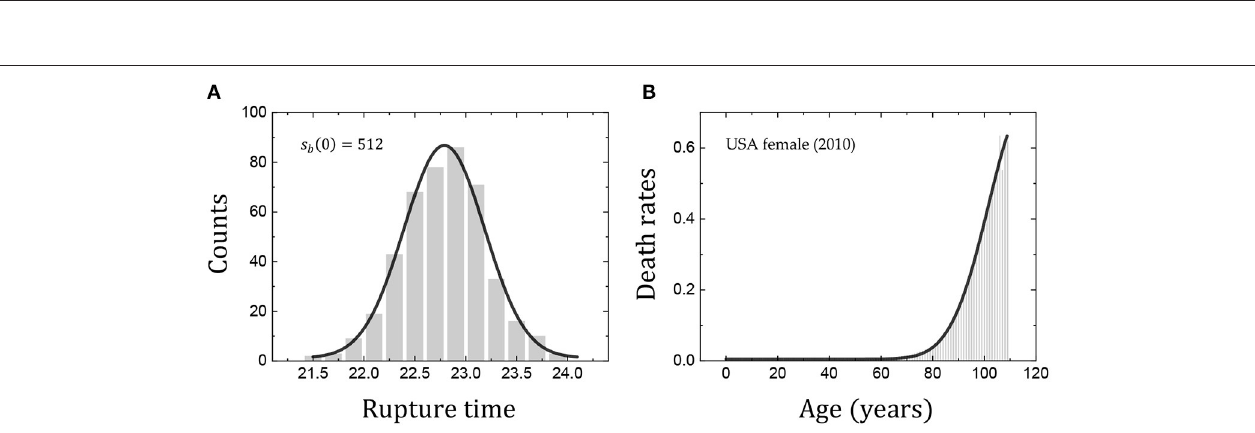
FIGURE 6 | Gaussian distributions of rupture times taken from s b (0) = 512 (in the Dataset 1 ) (from Figure 1B ) for clean foams (A) and of death rates taken from the USA female (2010, period 1x1) (from Figure 3D ) for humans (B) . The Gauss fits were carried out with the Origin software and described by the solid lines (adj. R 2 = 0.9851 in A and adj. R 2 = 0.9961 in B ). The Gaussian distributions found in both systems would be a reason for the analogous survival